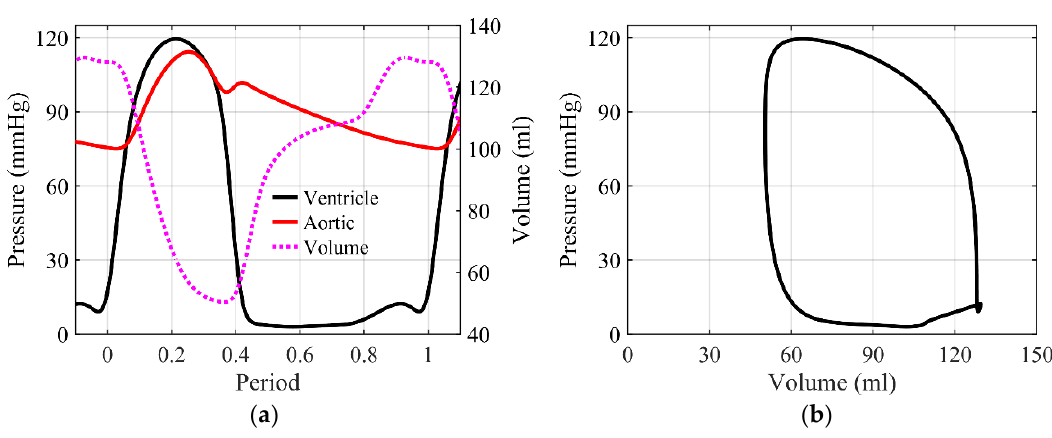
Figure 1. Human blood pressure waveform: ( a ) Wiggers diagram, redrawn based on https://commons.wikimedia.org/wiki/File:Wiggers_Diagram_2.svg; ( b ) ventricular pressure–volume loop.